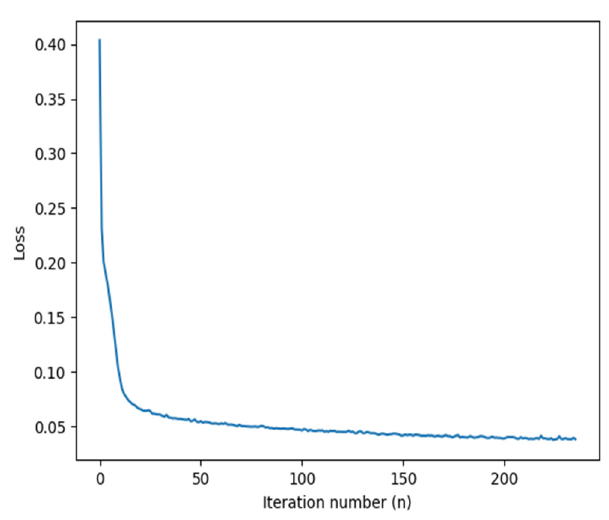
Figure 7. A plot showing variation in the loss value as a function of number of iterations for the model generated. Calibration point: reference plane A (probe tip); data predicted: dielectric permittivity spectrum.